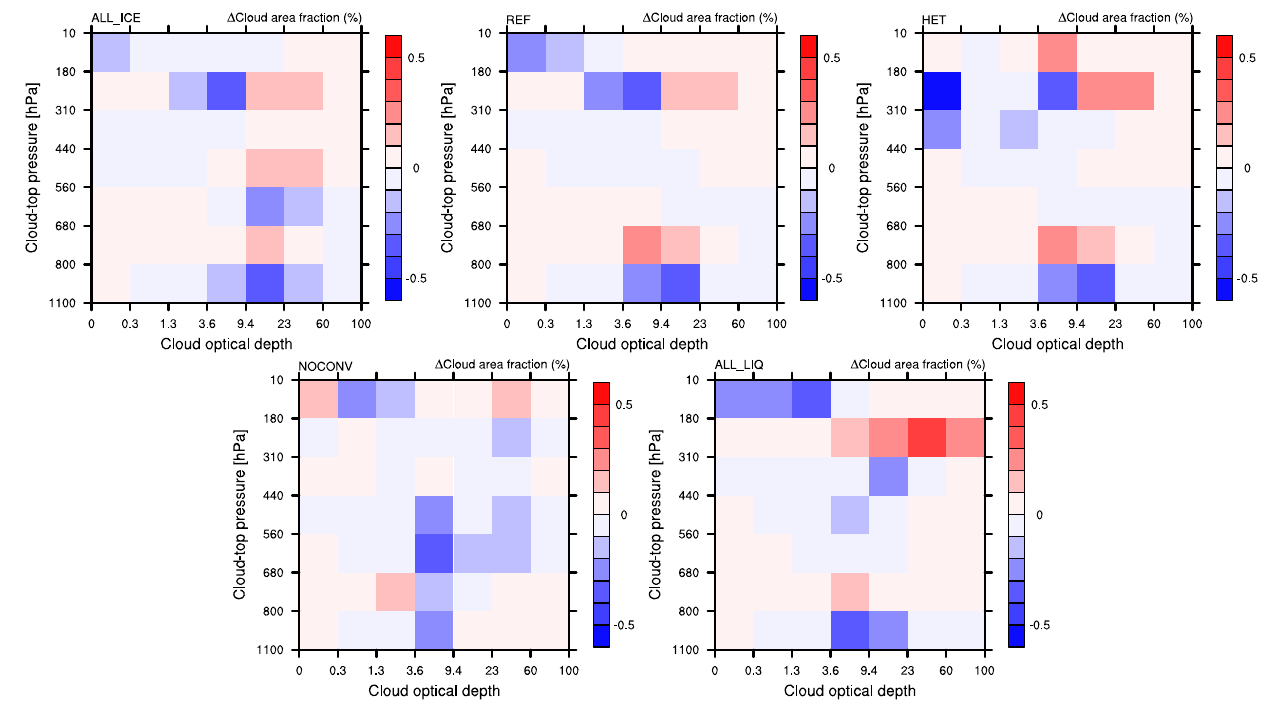
Figure 9. As Fig. 5 but for the tropics (15 ◦ S–15 ◦